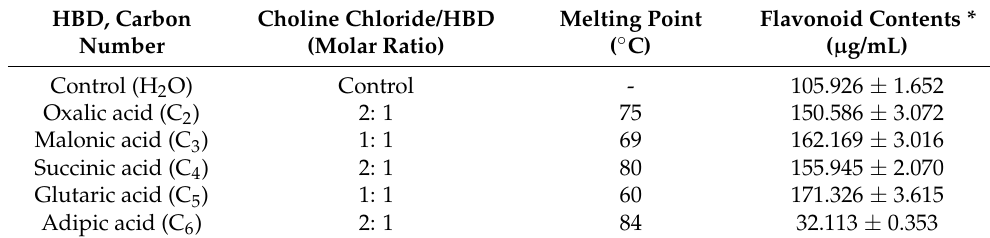
Table 1. Extraction efficiency of flavonoids from PUL .